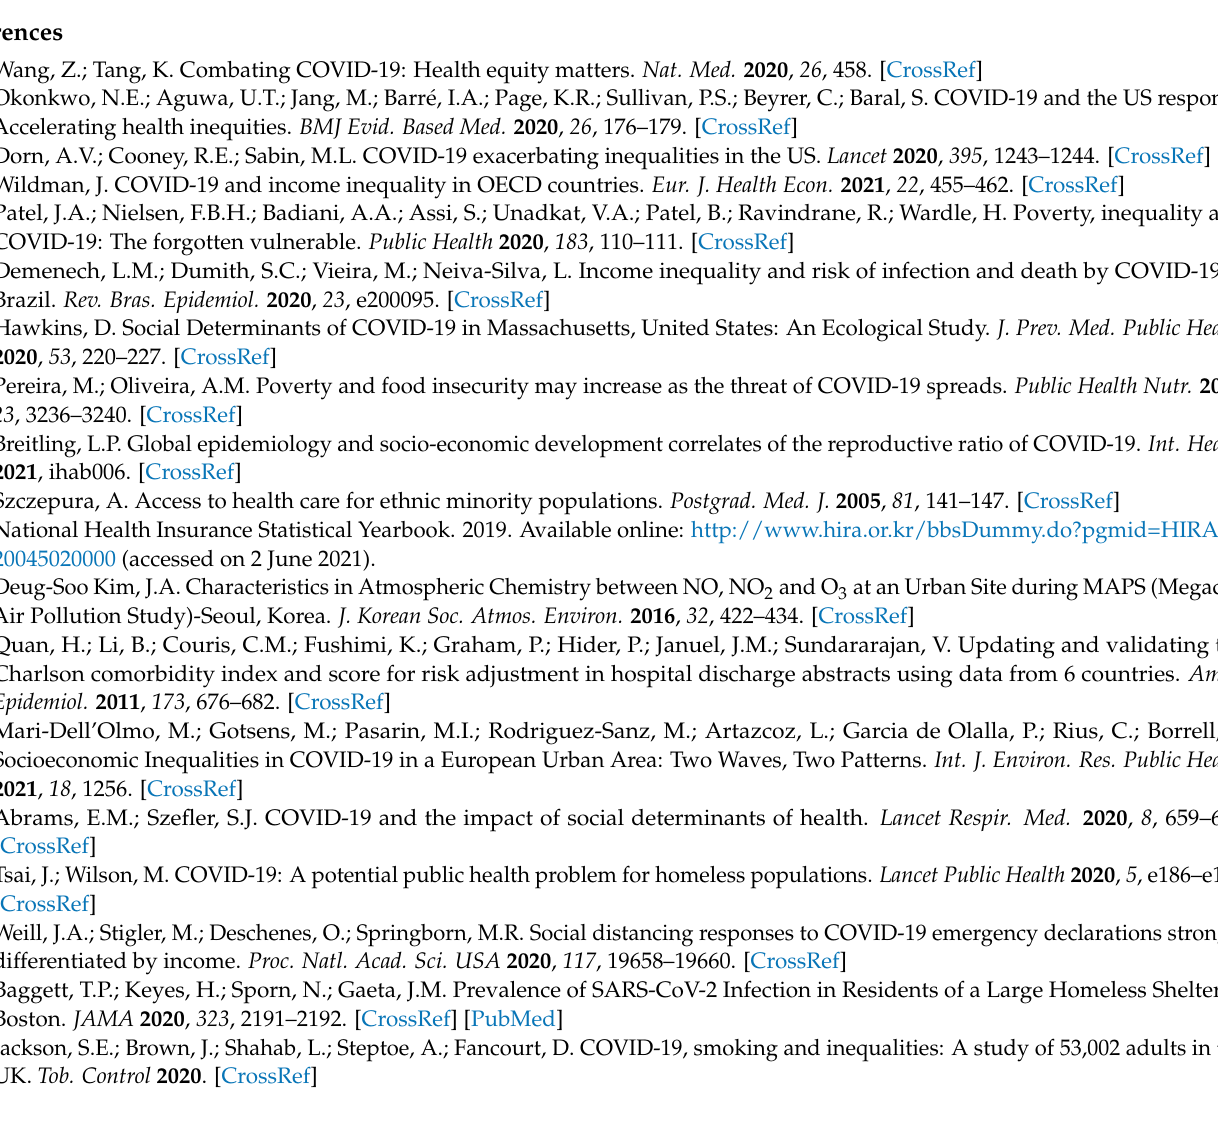
Table S4: Subgroup analyses of crude and adjusted odds ratios of the association of income with mortality in COVID-19 participants by